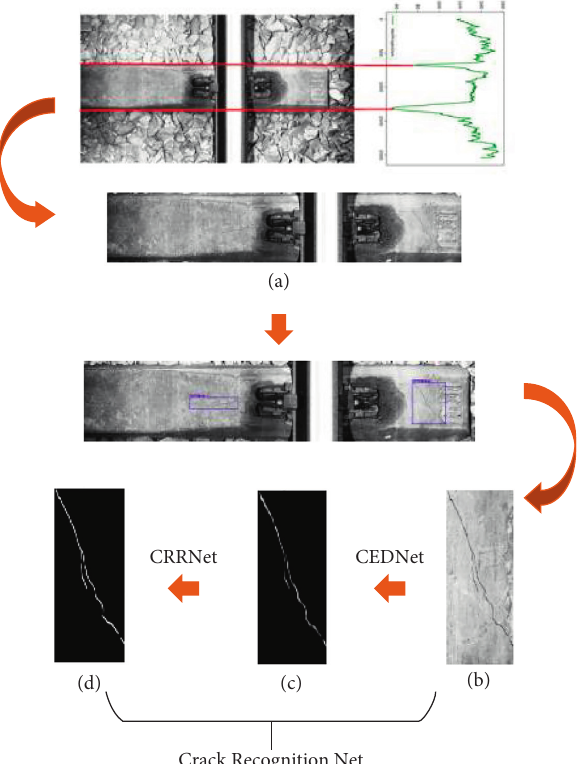
Figure 2: Process of the proposed method. (a) Gray